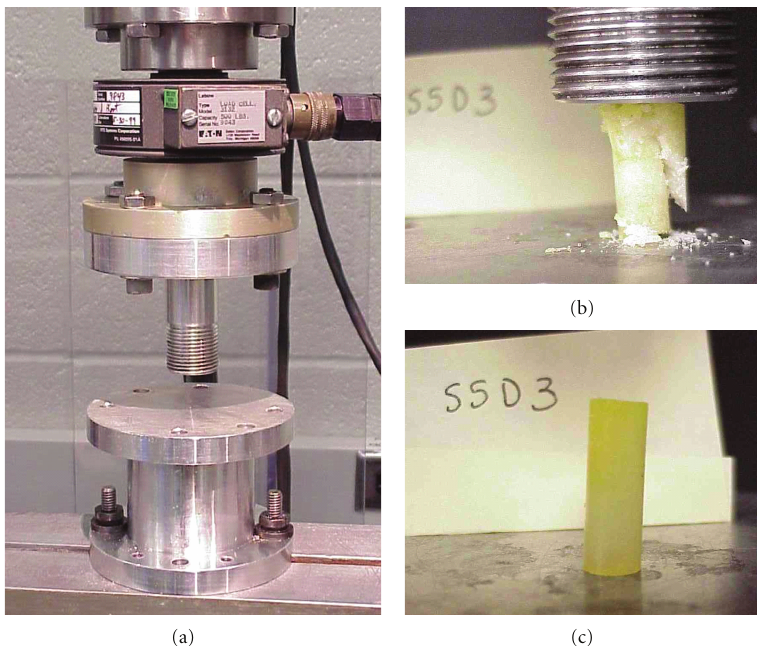
Figure 1: (a) The servohydraulic materials testing machine used in this study. (b) A representative PPF composite sca ff old incorporating mineralized bone fibers and sodium chloride porogen. The PPF cylinder was approximately 6 mm in diameter and 20 mm in height. (c) The specimen was placed between two solid platens and compressed at a rate of 0.1 mm/second.